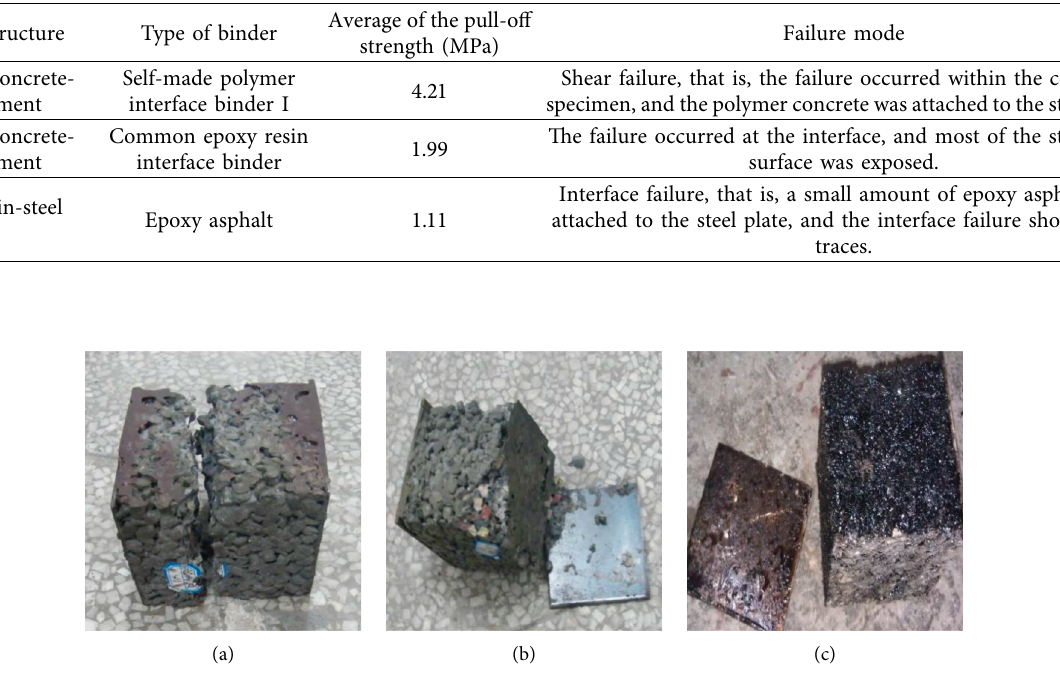
Figure 8: Interfacial shear failure of different interface binders. (a) Self-made polymer steel bridge deck pavement interface agent, (b) ordinary epoxy resin, and (c) epoxy asphalt. Table 5: Interfacial flexural properties of different interface-bonding